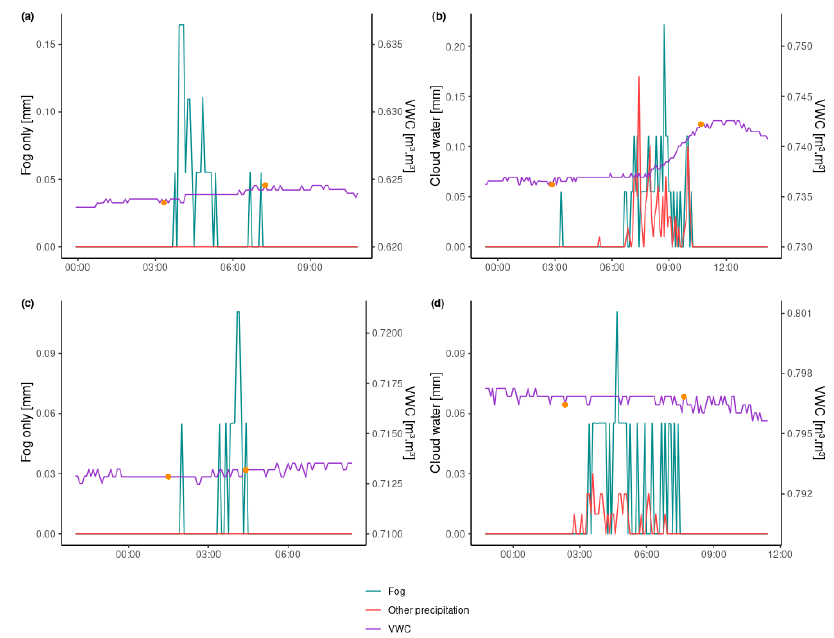
Figure 3. Some examples of the eighty two fog-only and cloud-water events and their corresponding soil volumetric water content ( VWC ) plotted considering four hours before and after the event. The orange dots represent a reference for the start and the end of the event, to calculate the change in VWC : ( a ) event 23, Class I event (producing an increase in VWC ) ( b ) event 19, Class I event (producing an increase in VWC ); ( c ) event 59, Class II event (producing no increase in VWC ), and ( d ) event 40, Class II event (producing no increase in VWC ). Table 1. Characteristics of fog-only and cloud-water events. Values of volumetric water content and meteorological variables are the mean value for each type of event independently they belong to Class I or Class II.